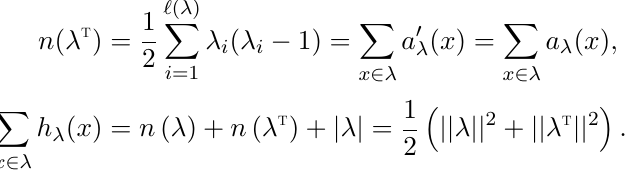
Figure 10 . Box contents of two types of Young diagrams. Depending on the parity of the representation (i.e. level (0 , ± 1) ), there are two types of box contents χ ( ± ) and χ ( − ) = vq − i . The arm direction is defined in the horizontal direction, while the leg vq i − 1 q j − 1 q − j x 1 2 1 2 direction is defined in the vertical direction for both parities of Young diagrams. The sets A ( λ ) and R ( λ ) are sets of addable boxes and removable boxes of the Young diagram,